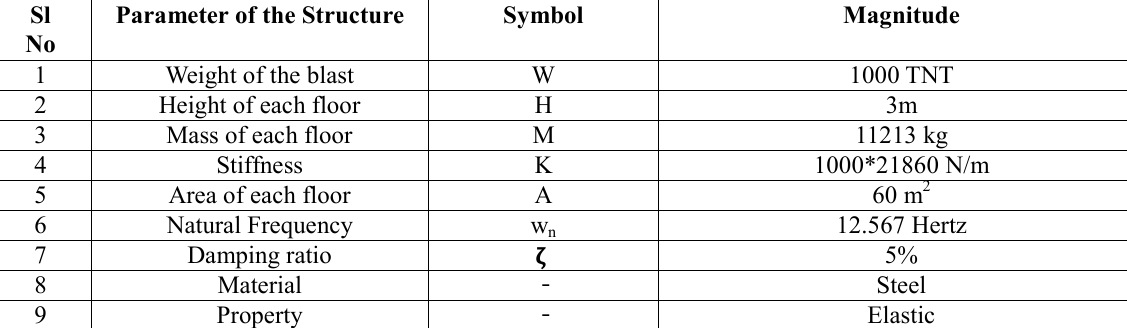
Input parameter of a